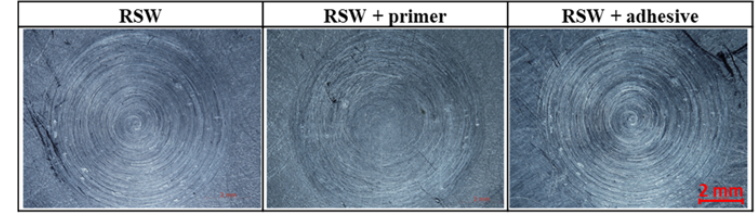
Figure 3. RSW weld face of examined samples .